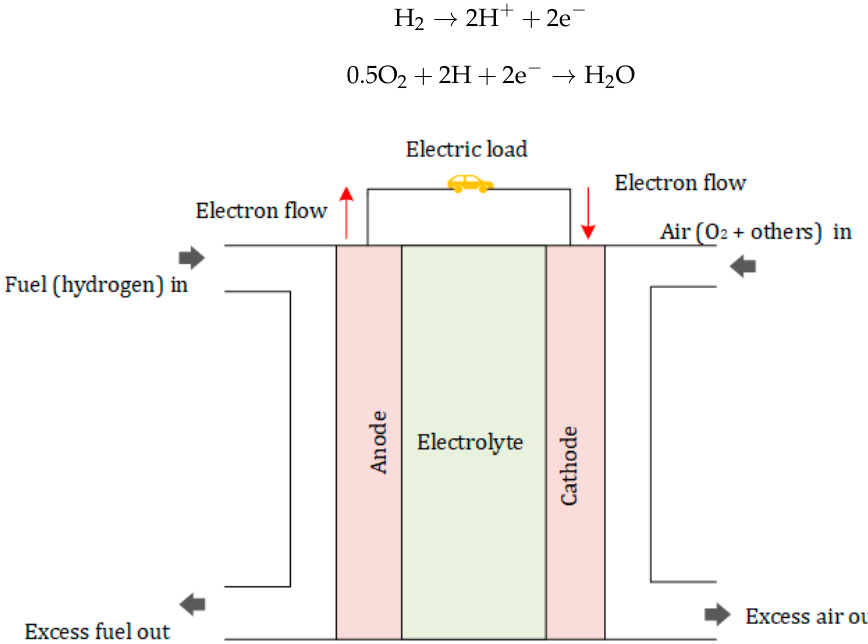
Figure 14. Model of a fuel cell.